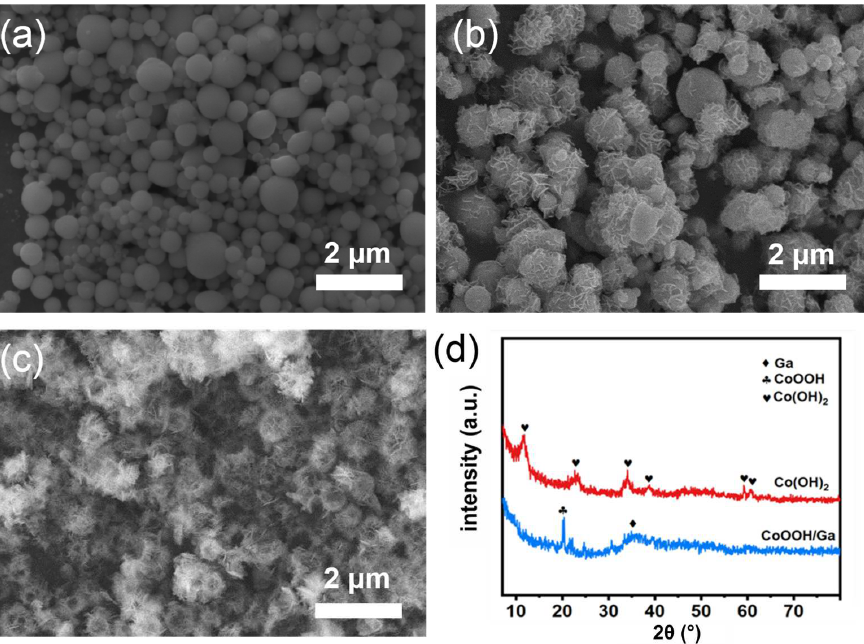
Figure 2. SEM images of ( a ) GaZn nanoparticles; ( b ) CoOOH/Ga; ( c ) Co(OH) 2 ; and ( d ) the XRD patterns of CoOOH/Ga and Co(OH) 2 . patterns of CoOOH/Ga and Co(OH) 2